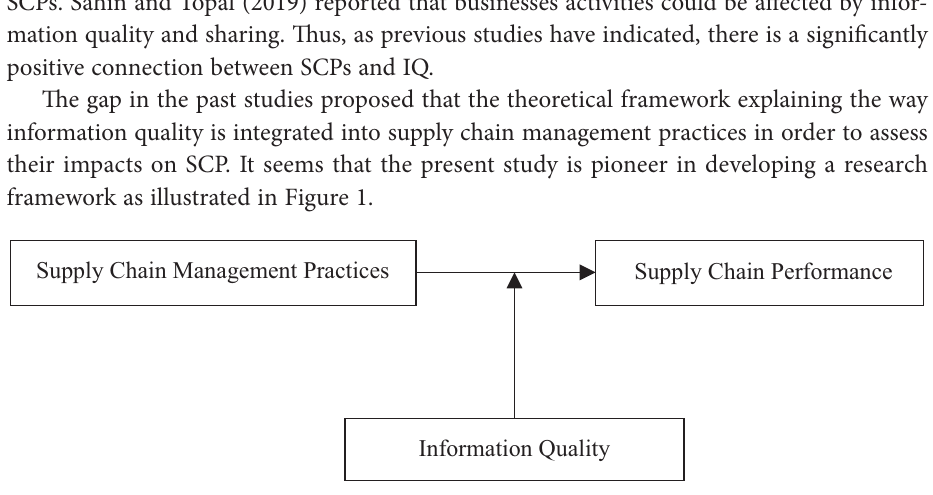
Figure 1. The theoretical framework illustrated the integrating of IQ into SCMPs to improve